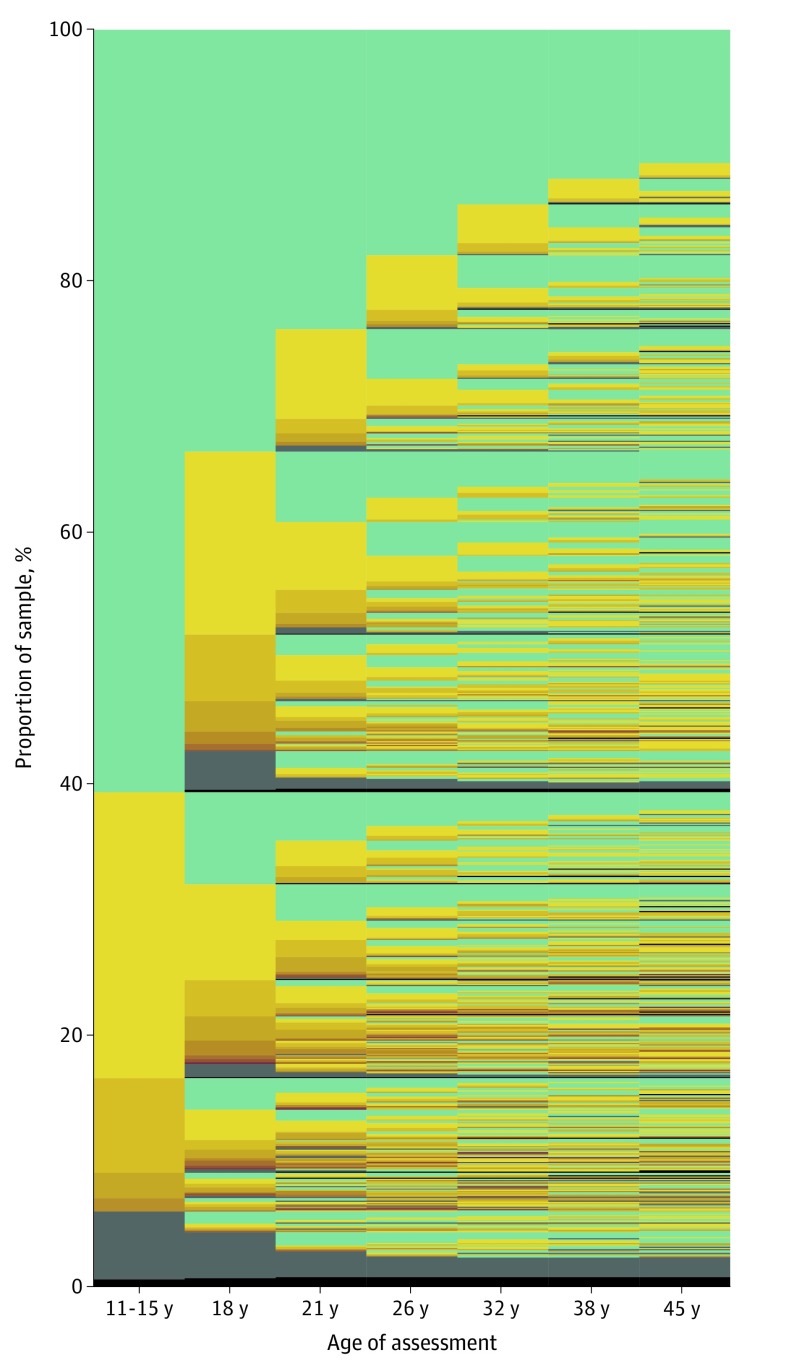
Natural History of Mental Disorders in a Cohort of 1037 IndividualsThe graph is made up of a thin line for each individual in the Dunedin Study stacked together to show the 1037 cohort members, followed from age 11 to age 45 years. Columns are assessment ages. Green signifies the absence of a mental disorder. Yellow signifies that an individual met the criteria for a psychiatric diagnosis at a given assessment age; as the yellow deepens into orange and brown, it signifies a greater number of concurrent disorders diagnosed for that individual. Gray signifies that a study member was missing at that assessment age. Black signifies that a study member had died.